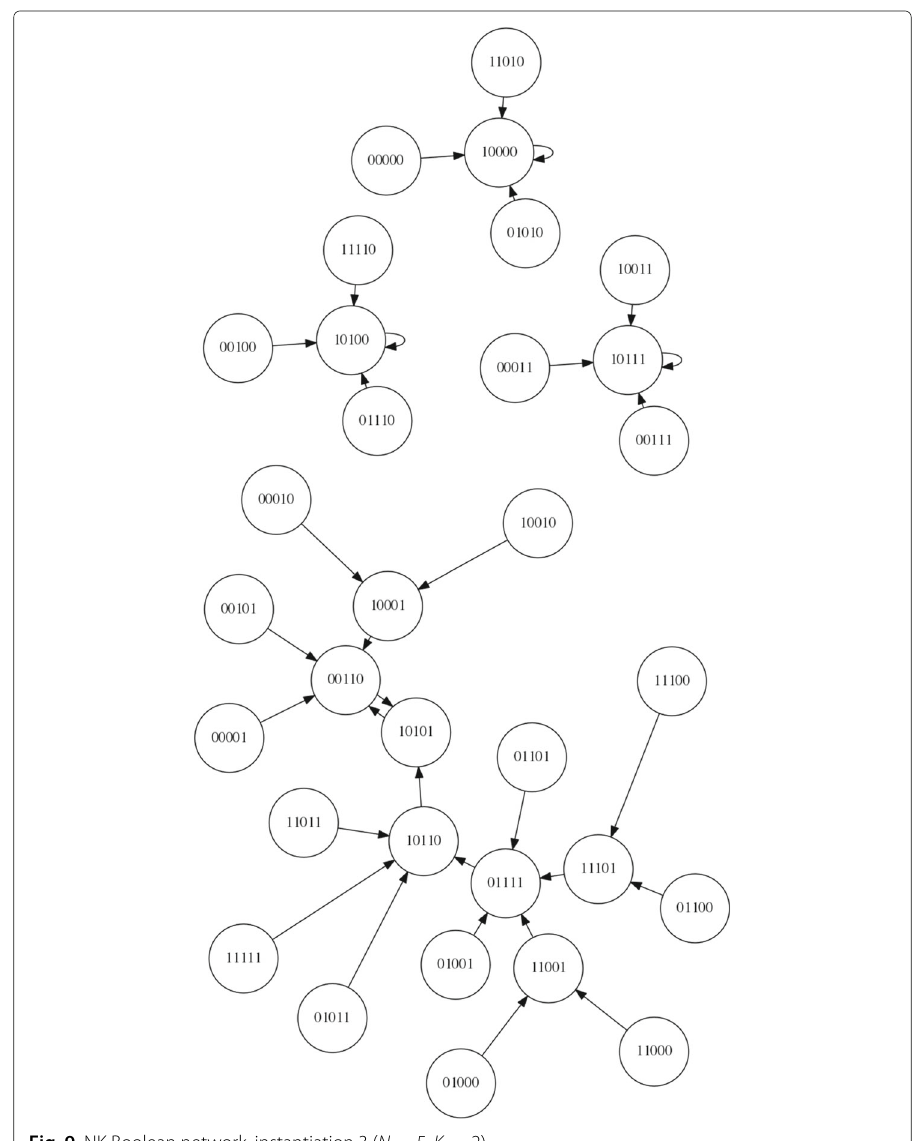
Fig. 9 NK Boolean network, instantiation 3 ( N = 5, K =